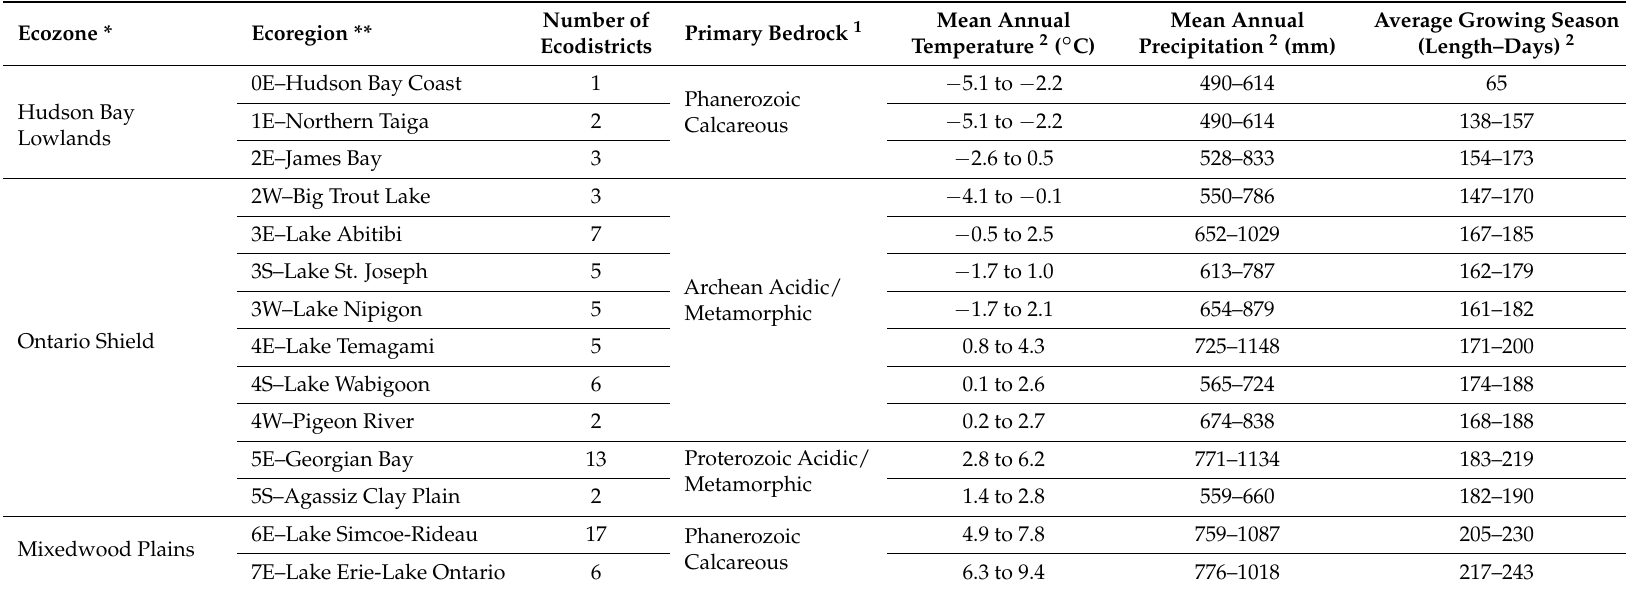
Table A1. Characteristics of ecozones and associated ecoregions in Ontario